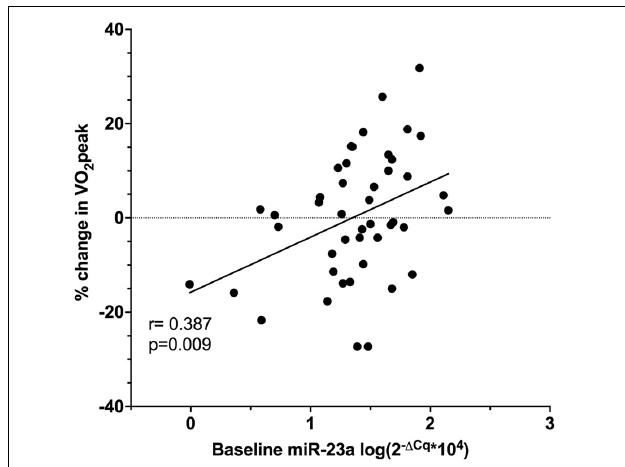
FIGURE 4 | Pearson correlation of baseline relative miR-23a expression and the percent change in VO 2 peak in ET ( n = 25) and UC ( n = 20).